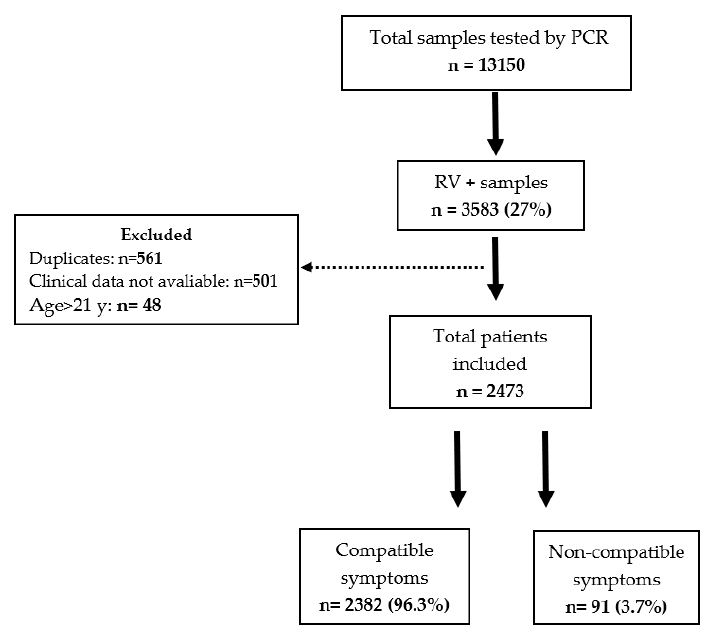
Figure 1. Flow diagram depicting the selection of study patients. Table 1. Respiratory diagnosis in patients with compatible symptoms ( n =